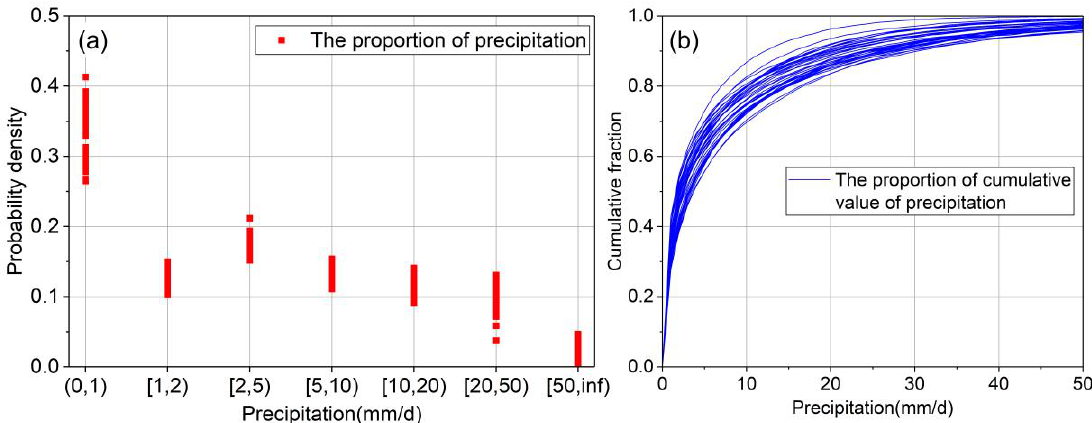
Figure 6. Statistical function of precipitation for 36 meteorological stations in the Xijiang River Basin between 1960 and 2008. ( a ) Probability density function; ( b ) cumulative distribution function. Square dots filled with red represent probability